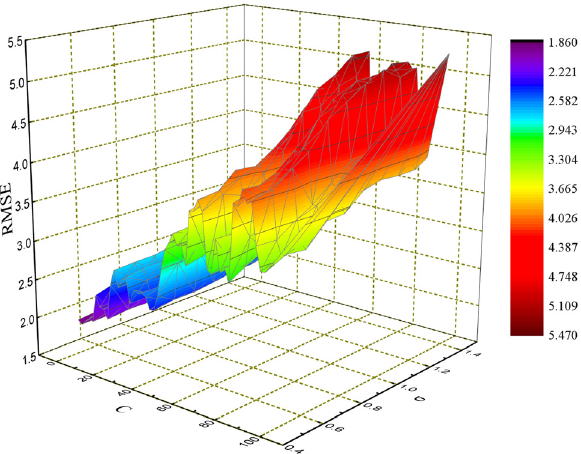
Figure 7: The variety of RMSE with σ and C in optimizing SVR ’ s